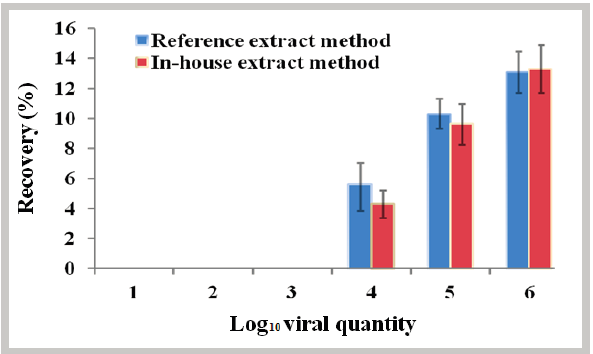
Figure A1. Comparison of two methods for the recovery of HEV inoculated into shellfish digestive tissue using qRT-PCR. Recoveries with the in-house method in comparison with the reference method at gradient initial viral quantity in 10 mL supernatant samples of shellfish digestive tissue. Recoveries by reference method with the same gradient initial viral quantity in individual shellfish digestive tissue directly. The detailed procedure of the reference